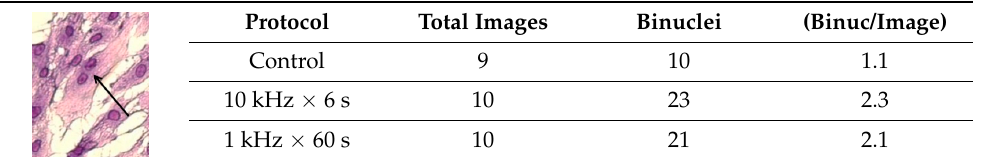
Table 5. Number of binucleated cells in the case of short pulse treatment with the same energy. Left: image of a binucleated fibroblast.